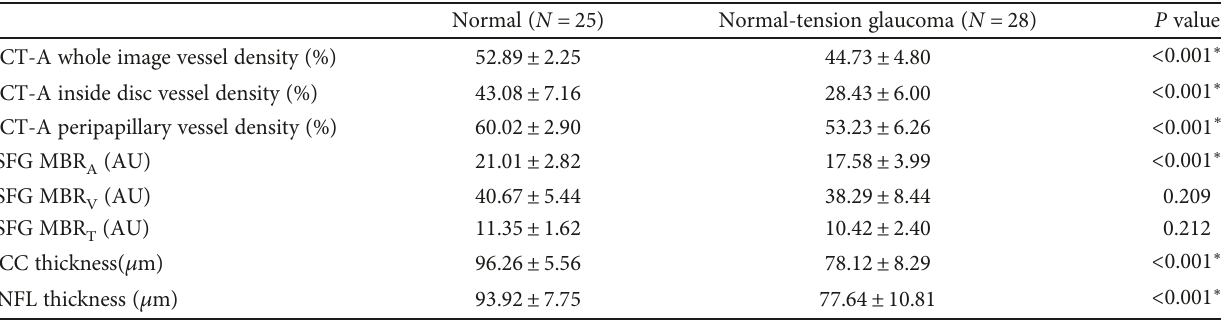
Table 2: Result of diagnostic testing.